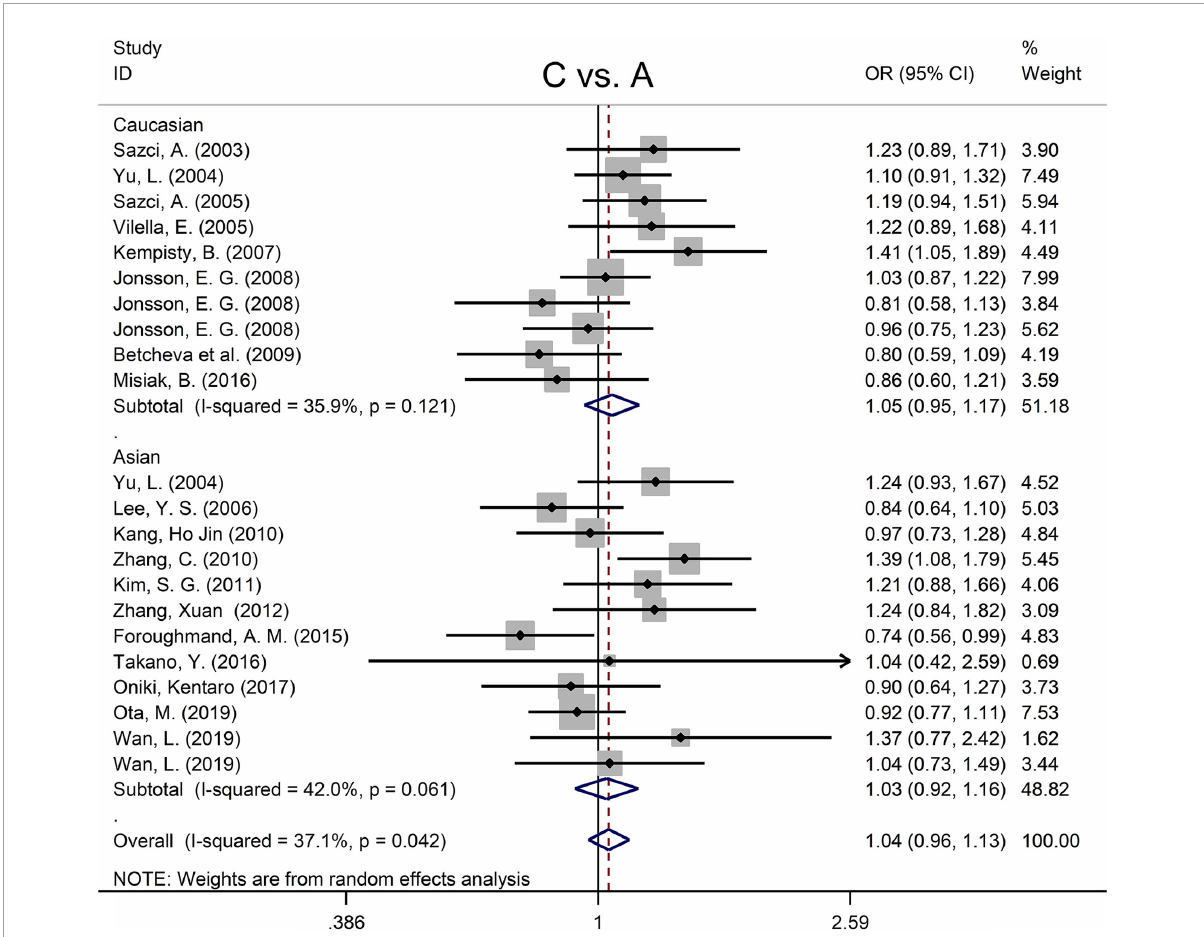
FIGURE3 Forest plots for the associations between MTHFR A1298C polymorphisms and SZ for the allele model with random effect model.